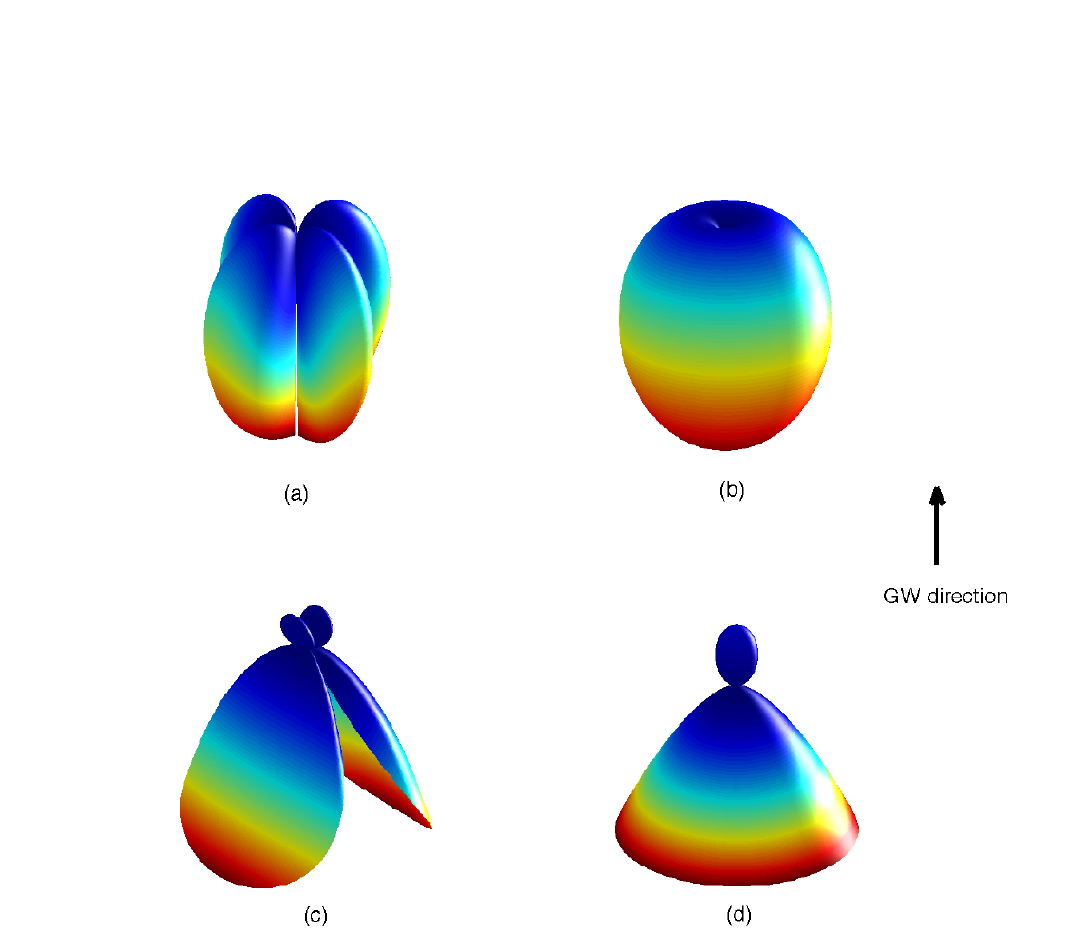
Figure 3: Antenna patterns for the pulsar-Earth system. The plus mode is shown in (a), breathing modes in (b), the vector-x mode in (c), and longitudinal modes in (d), as computed from Eq. (75). The cross mode and the vector-y mode are rotated versions of the plus mode and the vector-x mode, respectively, so we did not include them here. The gravitational wave propagates in the positive 𝑧 -direction with the Earth at the origin, and the antenna pattern depends on the pulsar’s location. The color indicates the strength of the response, red being the largest and blue the